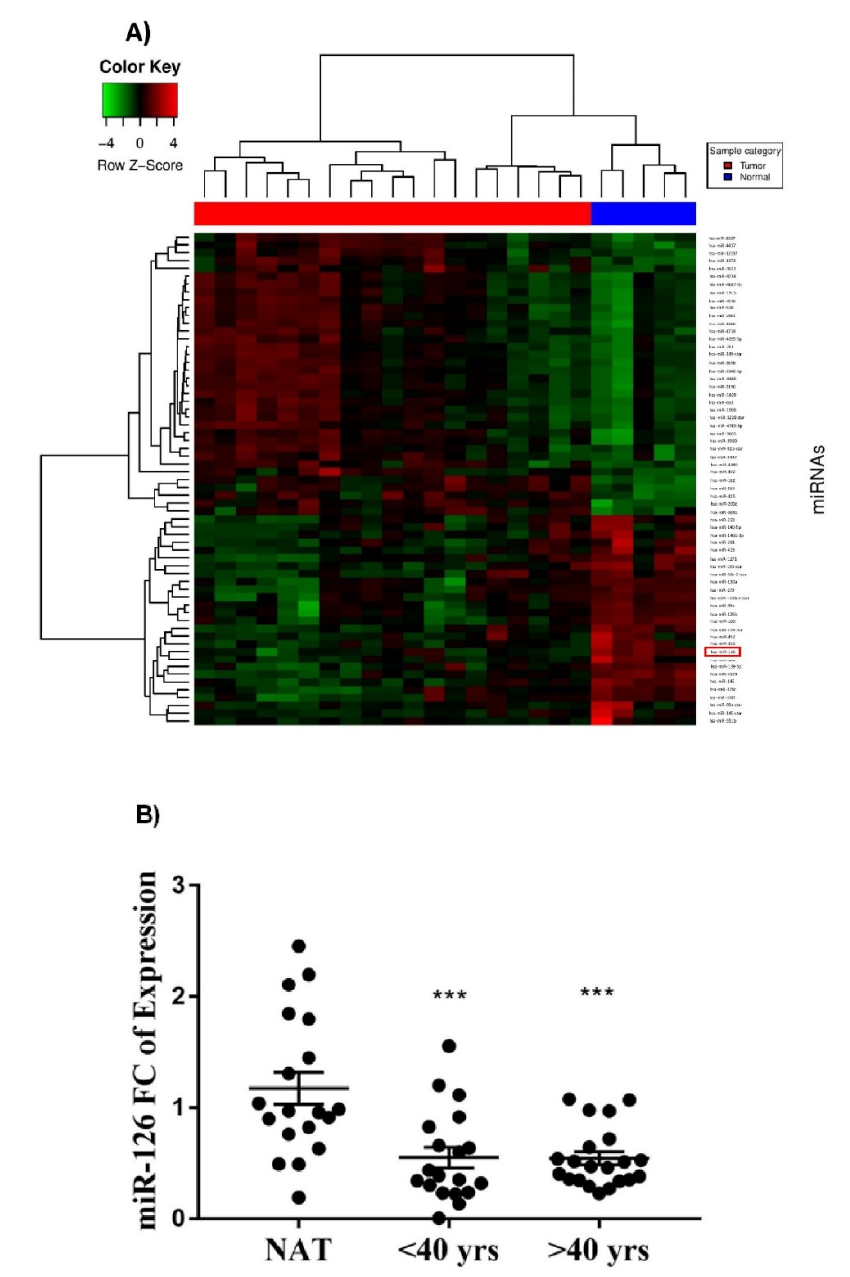
Figure 1. miR-126 expression in ER+ BC tissues versus NAT. ( A ) Heatmap of the differentially expressed miRNA in breast tumor tissue samples versus NAT taken from Lebanese ER+ BC patients < 40 years old (fold change > 2 and adjusted p -value < 0.05). Each row represents a differentially expressed miRNA and each column represents one of the 24 samples. The color key shown in the top left illustrates the relative expression level of an miRNA across all samples. ( B ) Dot plots show the fold change of miR-126 in 40 BC tissues normalized to the average of 19 NAT with RNU6B used as an endogenous control. Error bars represent SEM. *** denotes p <